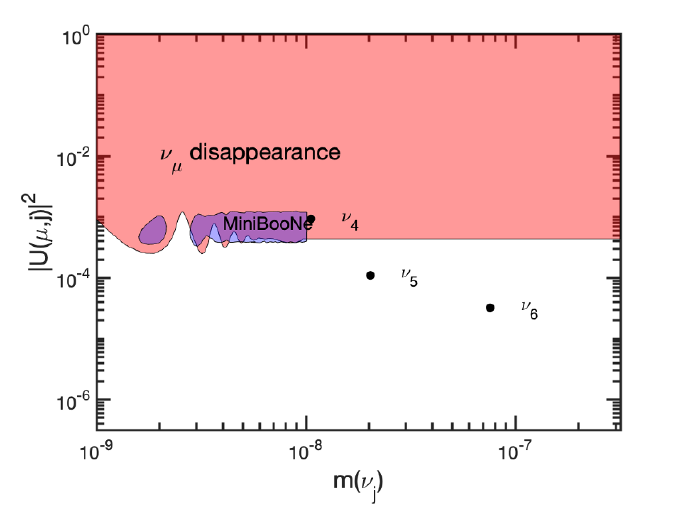
Figure 2 . Same as (cid:12)gure 1, but for mixing of muon